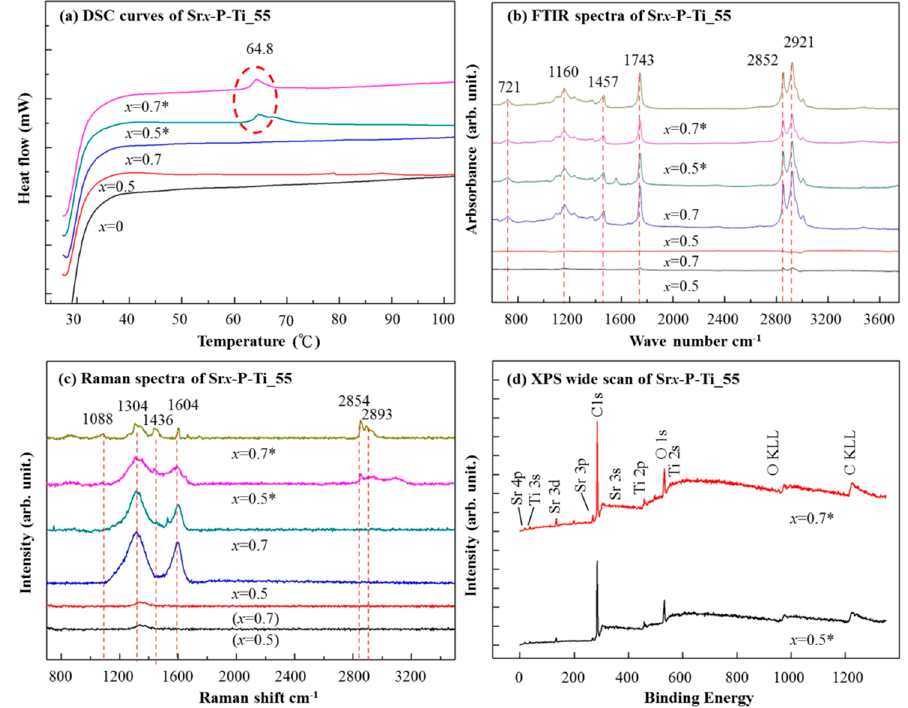
Figure 4. ( a ) DSC curves obtained from the samples Sr x -P-Ti_55 (x = 0, 0.1, 0.3, 0.5, and 0.7). ( b ) The characteristic peaks obtained from FTIR Spectroscopy for the biodiesel at 721, 1160, 1457, 1743, 2852, and 2921 cm − 1 . Note that x = 0.5 and x = 0.7 indicate the addition of olive oil without heating. ( c ) The characteristic peaks obtained from Raman Spectroscopy for the biodiesel at 1088, 1304, 1436, 1604, 2854, and 2893 cm − 1 . ( d ) Wide scan XPS spectra for Sr x -P-Ti_55 ( x = 0.5 and 0.7). Detailed information is discussed in the text.